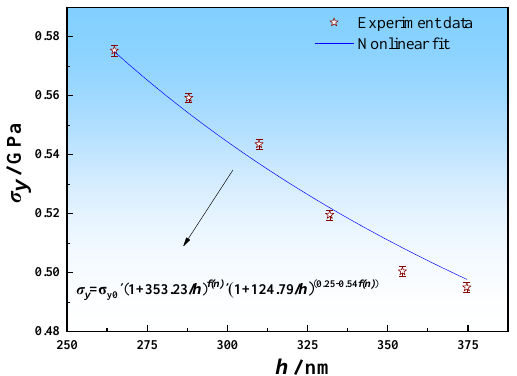
Figure 11. Relationship between σ y and h of the austenitic phase under different loads.